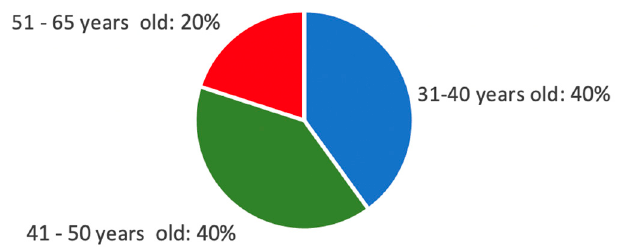
Figure 2. Percentage of age range.